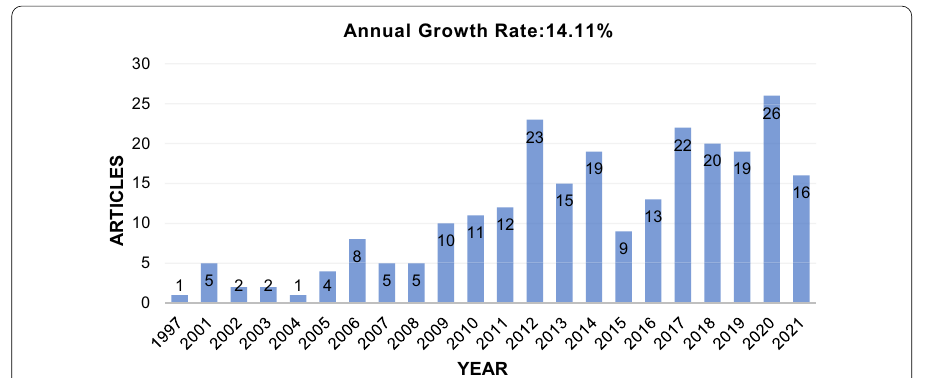
Fig. 2 Annual production of OFPD publications from 1997 to 2021